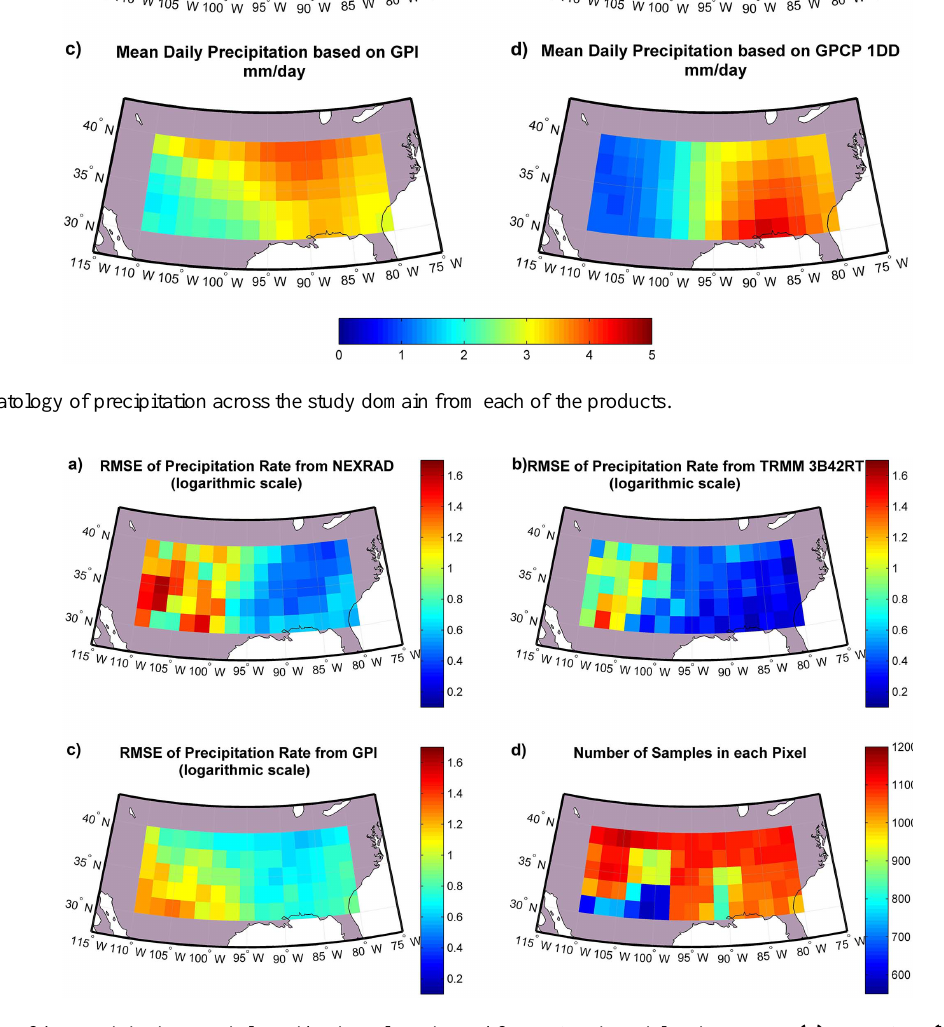
Figure 3. RMSE of the precipitation rate in logarithmic scale estimated from TC using triplets in group 1; (a) NEXRAD, (b) TRMM 3B42RT, (c) GPI. (d) shows the number of data points (biweekly measurements) in each pixel that are used for error estimation in TC